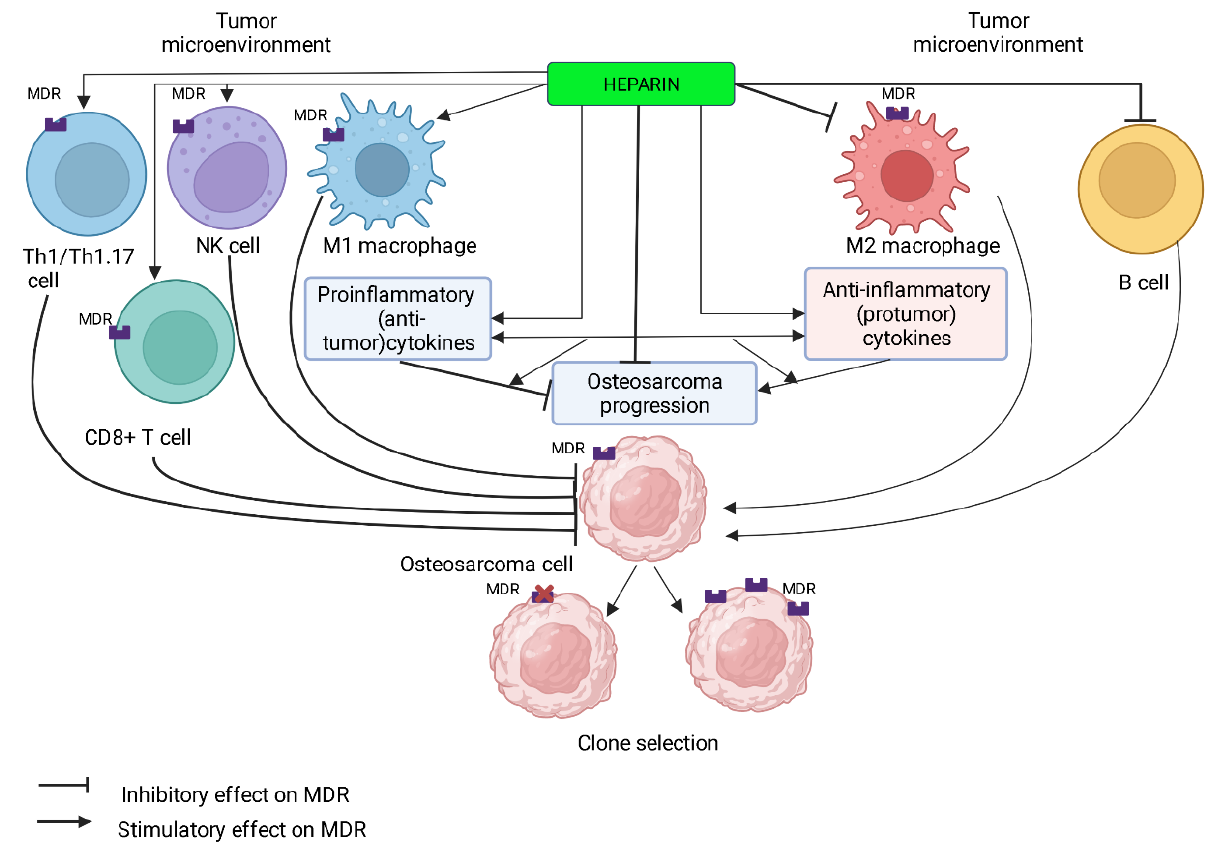
Figure 1. Potential pleiotropic effect of heparin on the development of multidrug resistance in tumor cells and the immune tumor microenvironment. Some cells of the immune tumor microenvironment play an antitumor role and secrete pro-inflammatory mediators (M1, Th1/Th1.17 cells, CD8+ cells, NK cells) that inhibit OS growth and MDR receptor expression. In contrast, other immune cells (M2, B cells) secrete anti-inflammatory factors and may have a positive effect on the progression of chem- otherapy-resistant tumor clones. Heparin is directly able to suppress in vitro the molecular mecha- nisms of MDR in OS cells and promote the selection of malignant cells sensitive to chemotherapy.